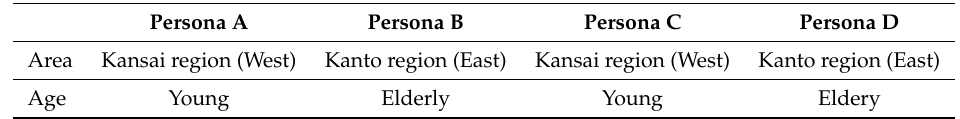
Table 5. Persona classification.